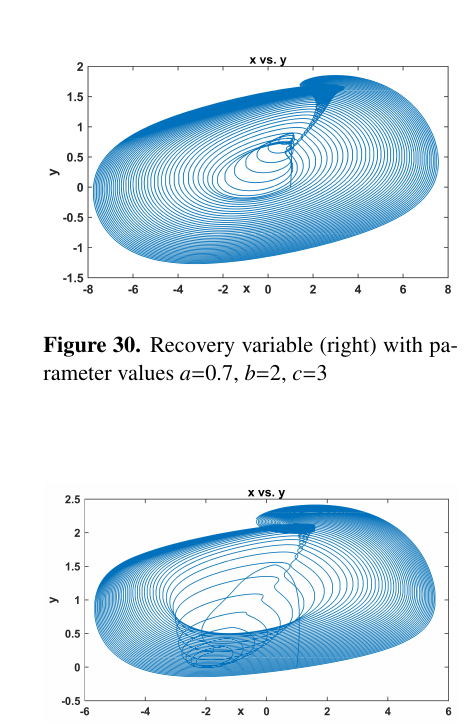
Figure 31. Responses of membrane potential with parameter values a = 2, b = 1.5, c = 1